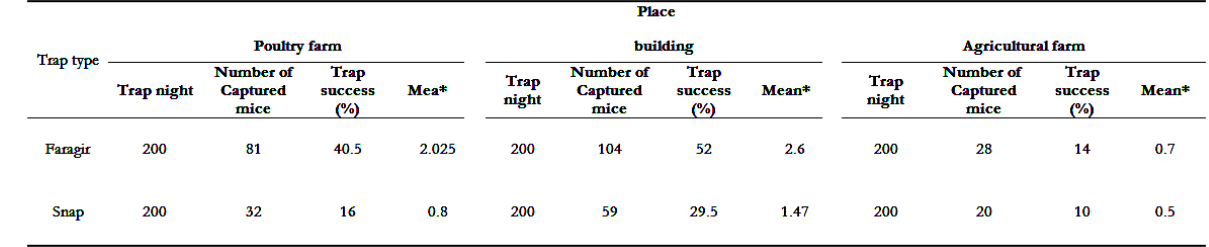
Table 1. Faragir and snap trap efficiency on Mus musculus in different